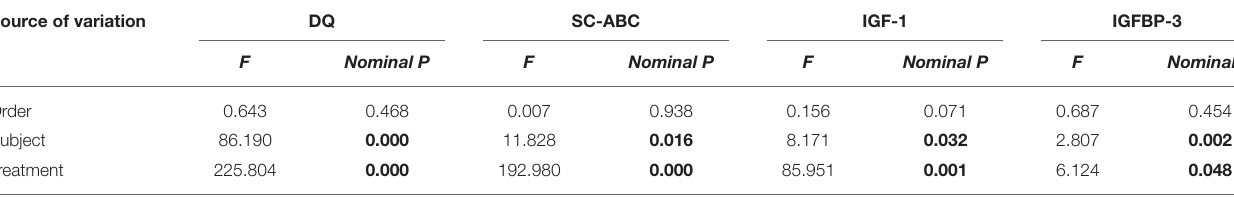
TABLE 3 | Analysis of variance of crossover data on main measurements value in two groups. Source of variation